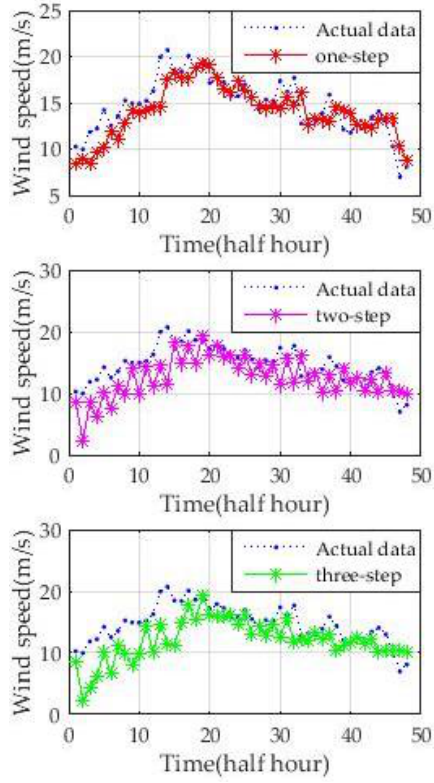
Figure 10. Forecasting results on 20 November 2004.